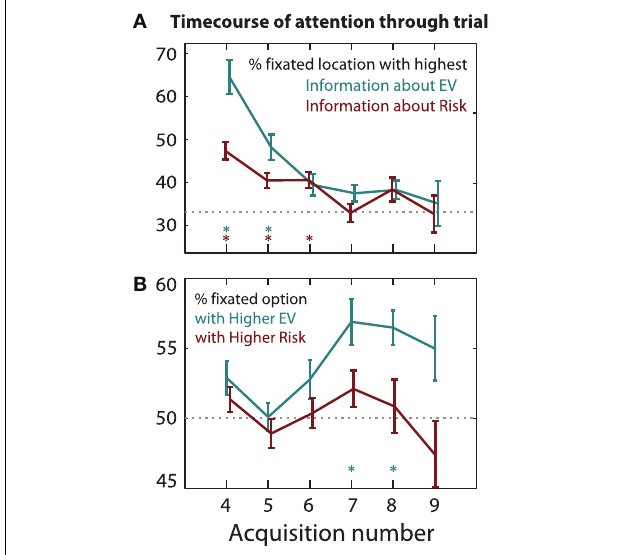
FIGURE 9 | Timecourse of attentional control. (A) Early on in a trial, attention is drawn by information. There is a strong pull by information about expected value, as calculated by Bayesian updating. The y-axis shows how often participants’ saccades coincide with the information-seeking prediction. This falls to chance (33%) after the sixth acquisition in a trial. There is a weak effect of information about risk. Asterisks denote acquisitions when gaze was significantly drawn toward the highest information, relative to chance ( p < 0 . 05). (B) Participants increasingly tend to fixate on the option with higher EV through a trial. For both (A,B) , EV and risk estimates for participants’ fixation sequences π ( EV | e 1 , e 2 ... e i ) were calculated using Bayesian updating rules using σ = 15.